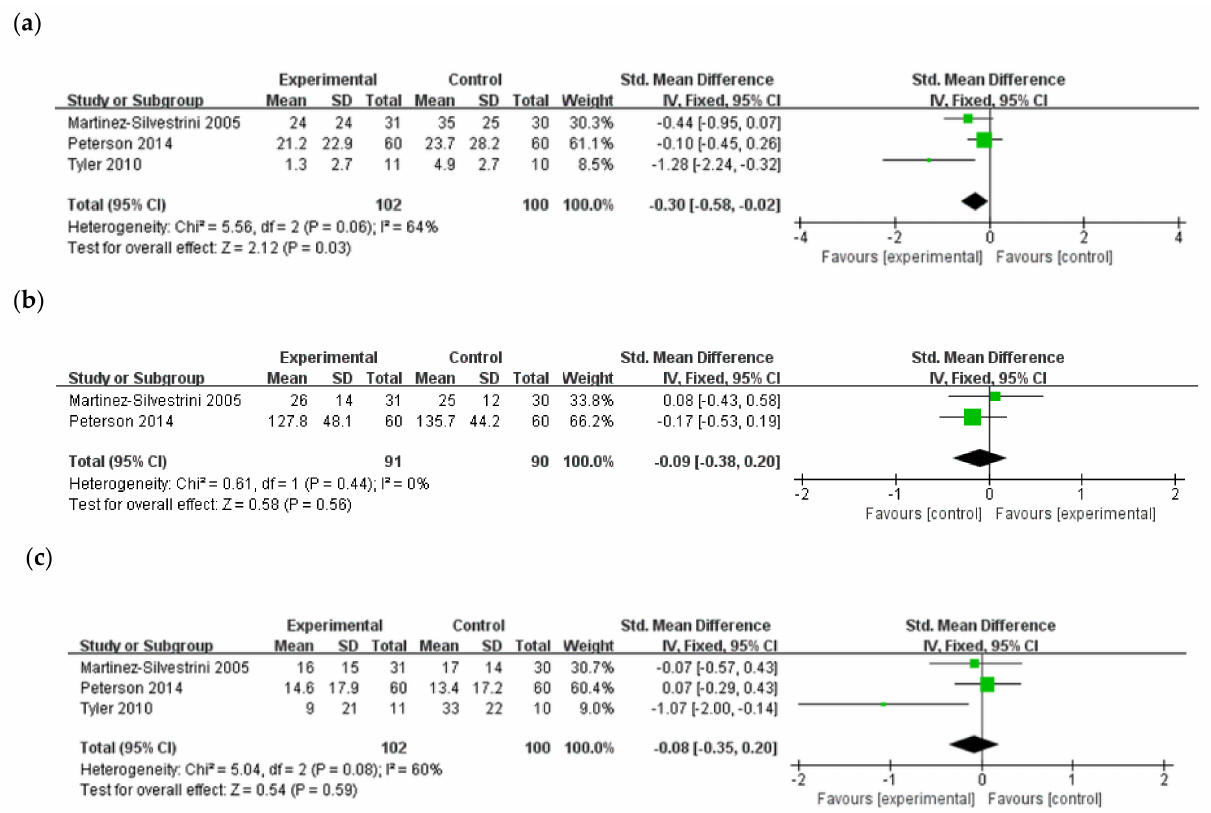
Figure 4. Effects of eccentric exercise compared with those of other exercise (concentric or isotonic) on ( a ) pain intensity, ( b ) muscles strength, and ( c ) function in lateral elbow